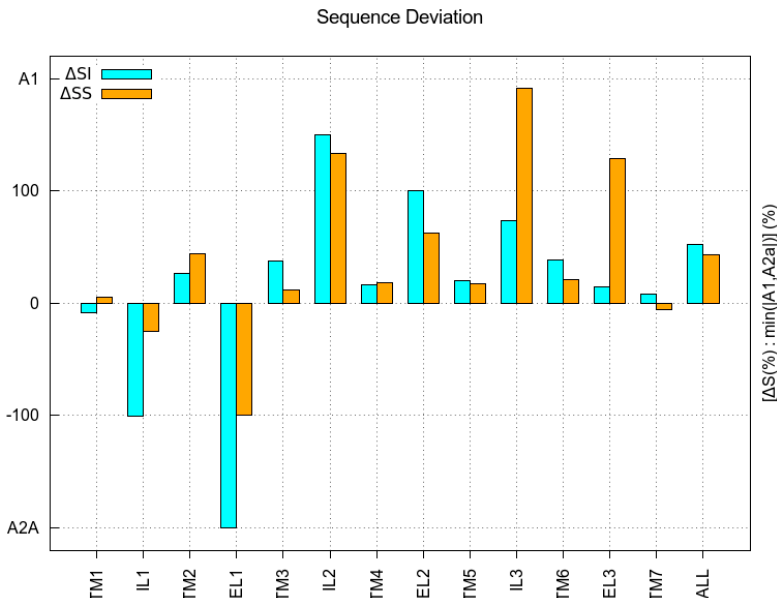
Figure 5. Sequence comparison calculations on each topological position and overall alignment. The percentage reported on the y -axis indicates how much the difference in identity ( ∆ SI, cyan), or in similarity ( ∆ SS, orange), favors alignment towards the hA1 or hA2a AR.